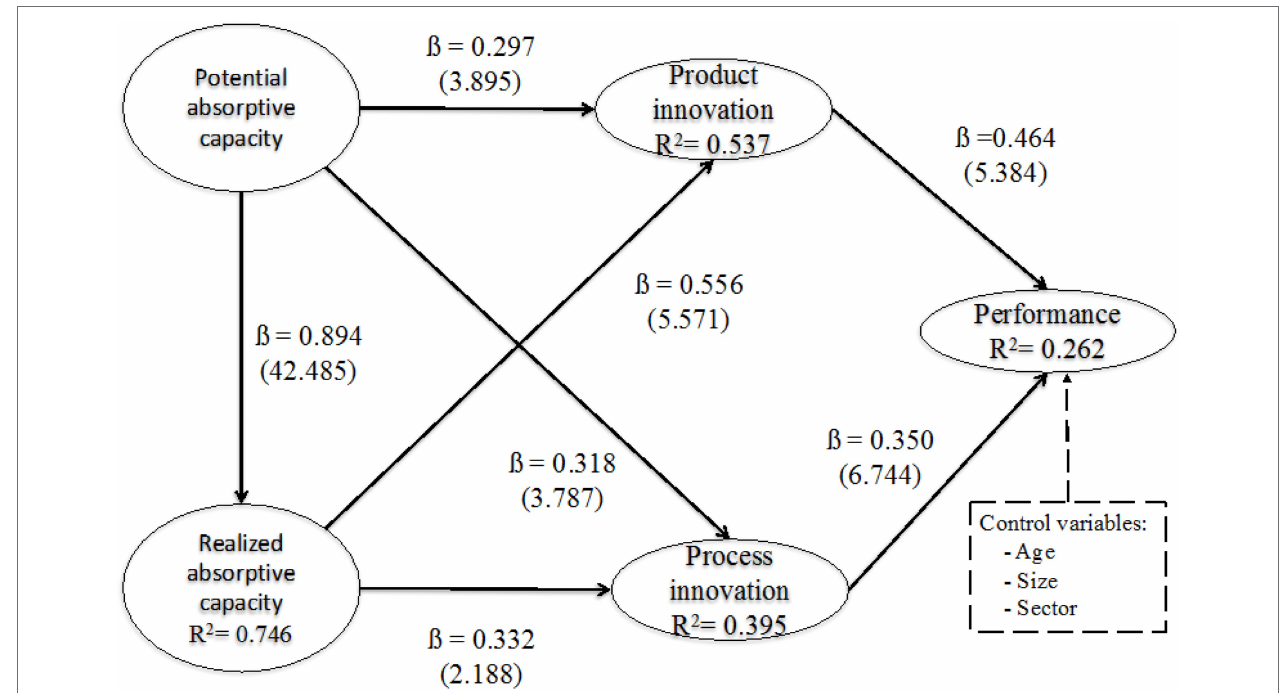
FIGURE 1 | Structural